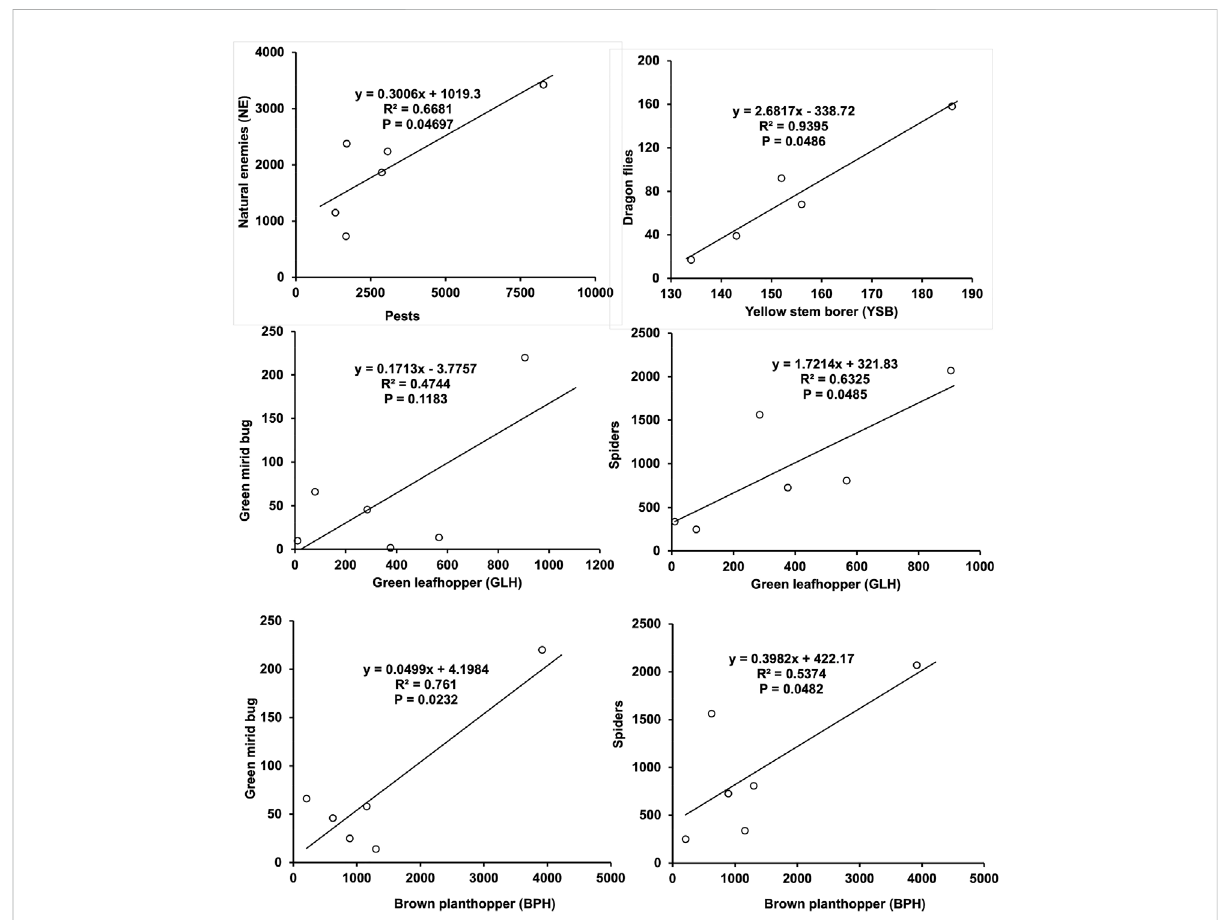
FIGURE 3 Simple linear regression showing natural enemy – prey association between important economic insect pest species in rice. Spatio-temporal changes of the landscape and LUM